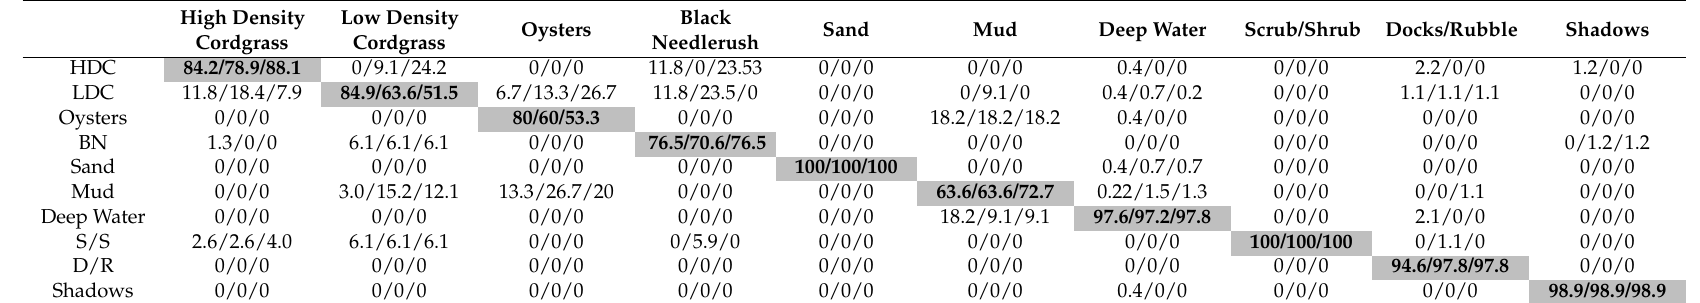
Table 3. Overall map accuracies for WV-2 supervised classification